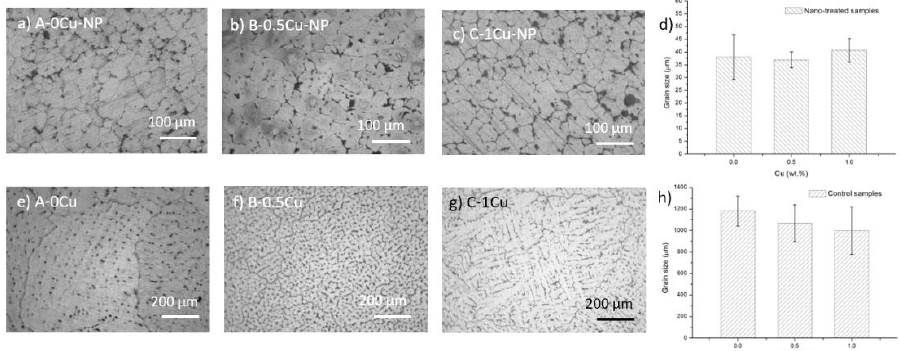
Figure 1. Optical images of etched nano-treated samples, ( a ) A-0Cu-NP, ( b ) B-0.5Cu-NP, ( c ) C-1Cu-NP, and ( d ) grain sizes. Optical images of etched control samples, ( e ) A-0Cu, ( f ) B-0.5Cu, ( g ) C-1Cu, and ( h ) their grain sizes.